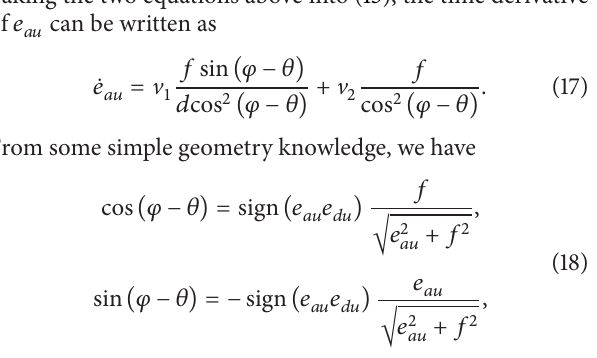
Figure 5: Find overlapping region of initial FOV and end FOV in the second